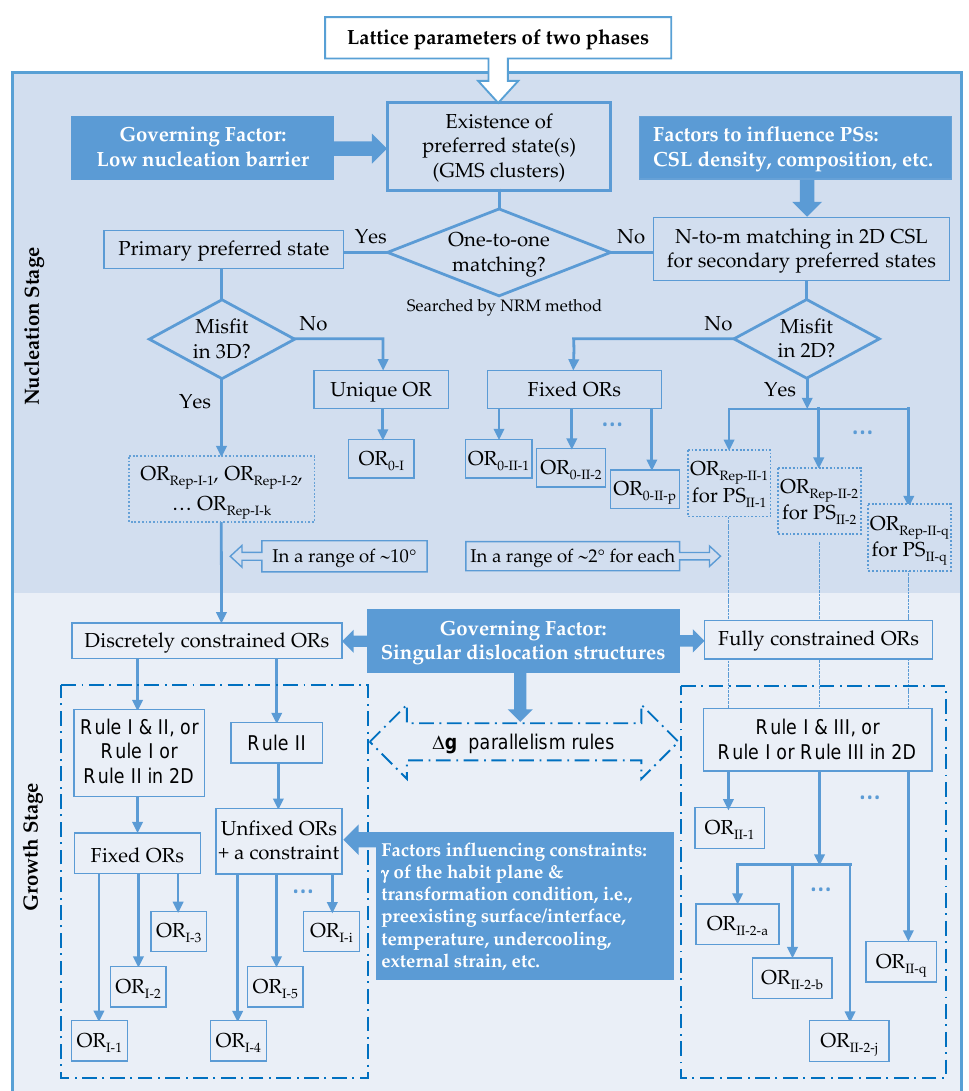
Figure 4. A schematic diagram illustrating the development of reproducible ORs at nucleation and growth stages. The definitions of abbreviations used in the chart are OR = orientation relationship, PS = preferred state, GMS = good-matching site, and NRM = near- row matching. The indications of subscripts are I = primary preferred state; II = secondary preferred state; Rep = representative OR; 0 = zero or almost zero misfit; and a, b, i, j, k, p, and q = integers to distinguish different ORs.